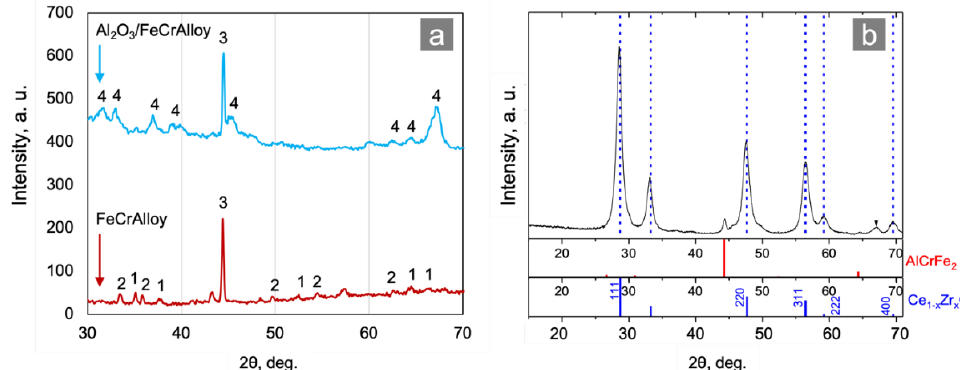
Figure 2. XRD patterns of the Al 2 O 3 /FeCrAl and FeCrAl: ( a ) 1—reflexes of α -Al 2 O 3 , 2—Fe and Cr (oxides), 3—Fe, Cr (metals), and 4— θ -Al 2 O 3 ; and ( b ) a sample of the supporting coating.